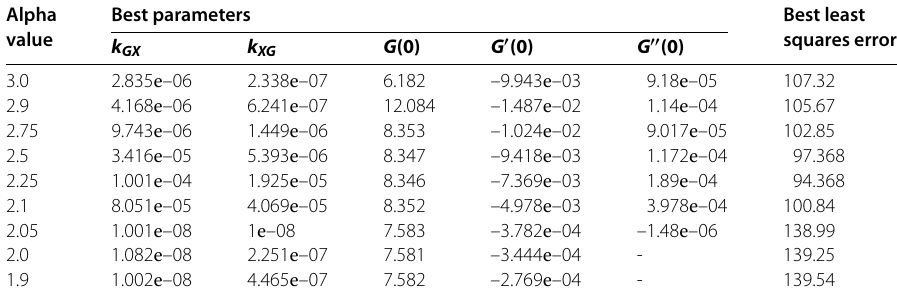
Table 5 Best least squares fits for fractional alpha model for subject 5 CGM data